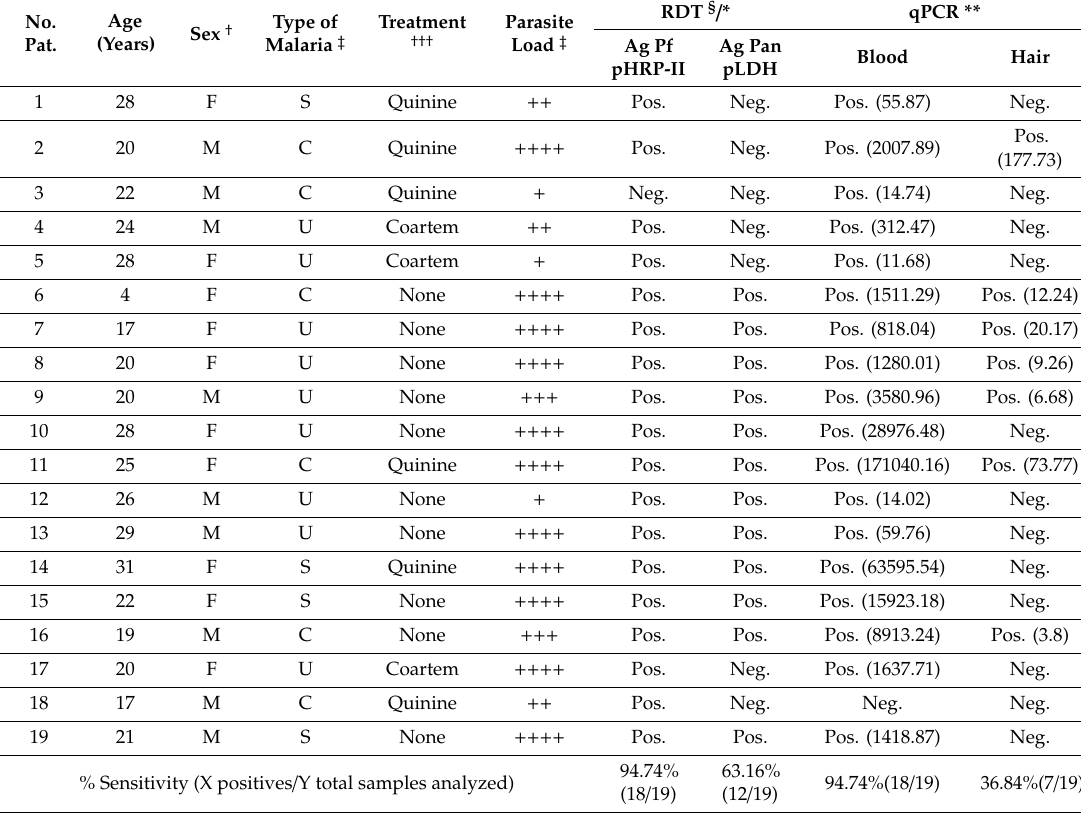
Table 1. Summary of clinical data, parasitological and immunological results of the 19 malaria patients. No.